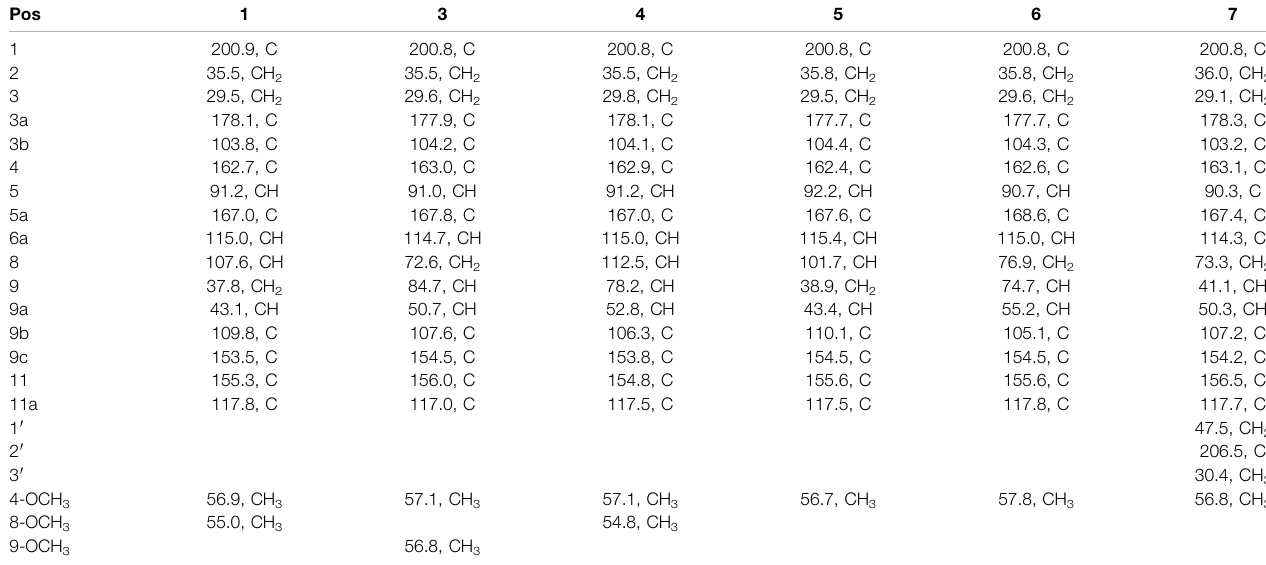
TABLE 3 | 13 C NMR data of compounds 1 , 3 , 4 in acetone- d 6 and 5 - 7 in pyridine- d 5 at 125 MHz.